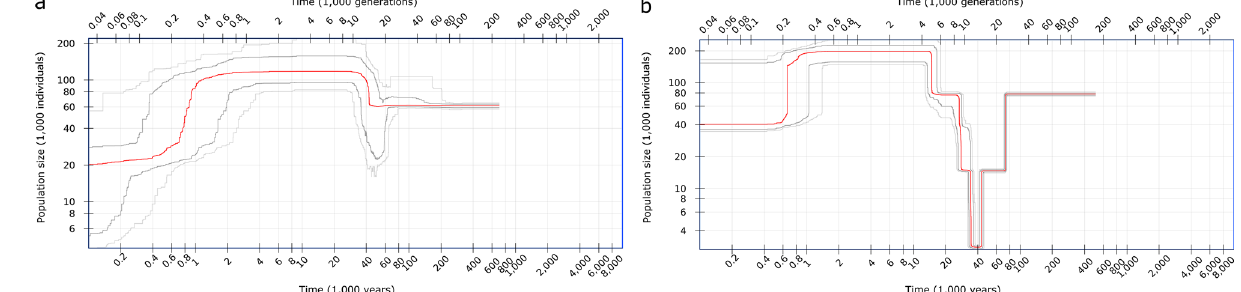
Figure 5. Effective population size of C. falcatum subsp. australe (a) and subsp. littorale (b) in chronological order estimated by Stairway plot. The x-axis is the time in thousand years (lower scale bar) and in thousand generations (upper scale bar) before present. The y-axis is the effective population size in thousand individuals. The red line shows median of effective population size. The upper and lower thick and light gray lines show 75% and 95% confidence intervals,